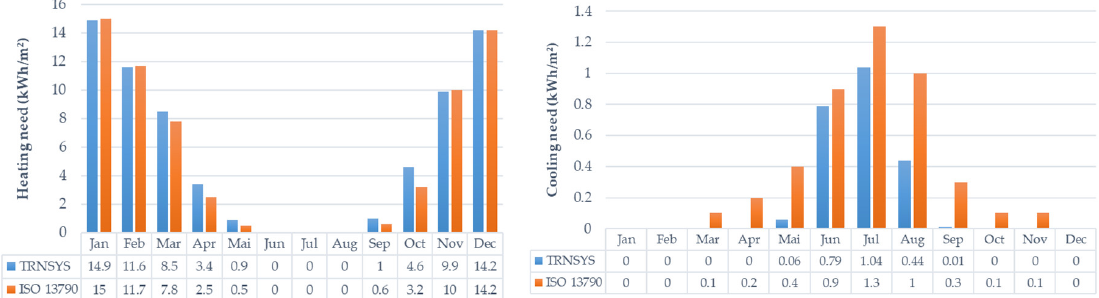
Figure 9. Comparison of energy simulation results obtained with TRNSYS and ISO-based CityBEM for a residential building (1985).